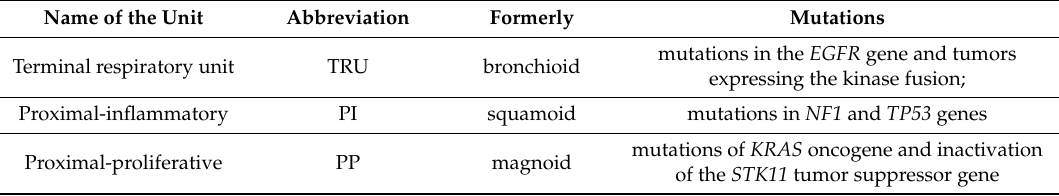
Table 4. The molecular classification of adenocarcinoma proposed by The Cancer Genome Atlas Consortium (TCGA)